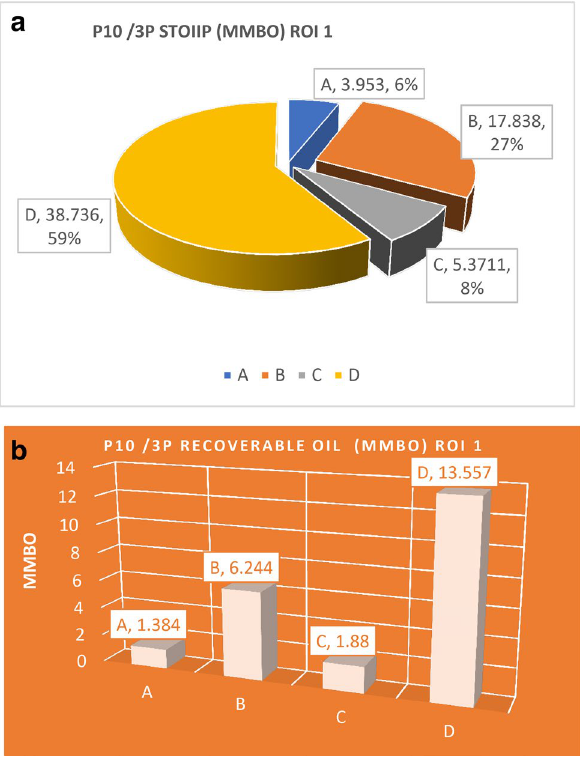
Fig. 11 a P10/3P STOIIP pie chart of reservoirs A–D at ROI 1. b P10/3P recoverable oil chart of reservoirs A–D at ROI